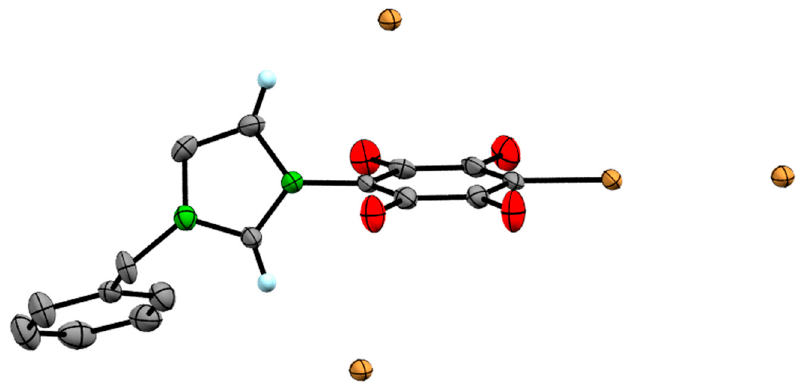
Figure 1. Hydrogen bond donor sites of the 1,3-disubstituted imidazolium cation showing the la- beling scheme.